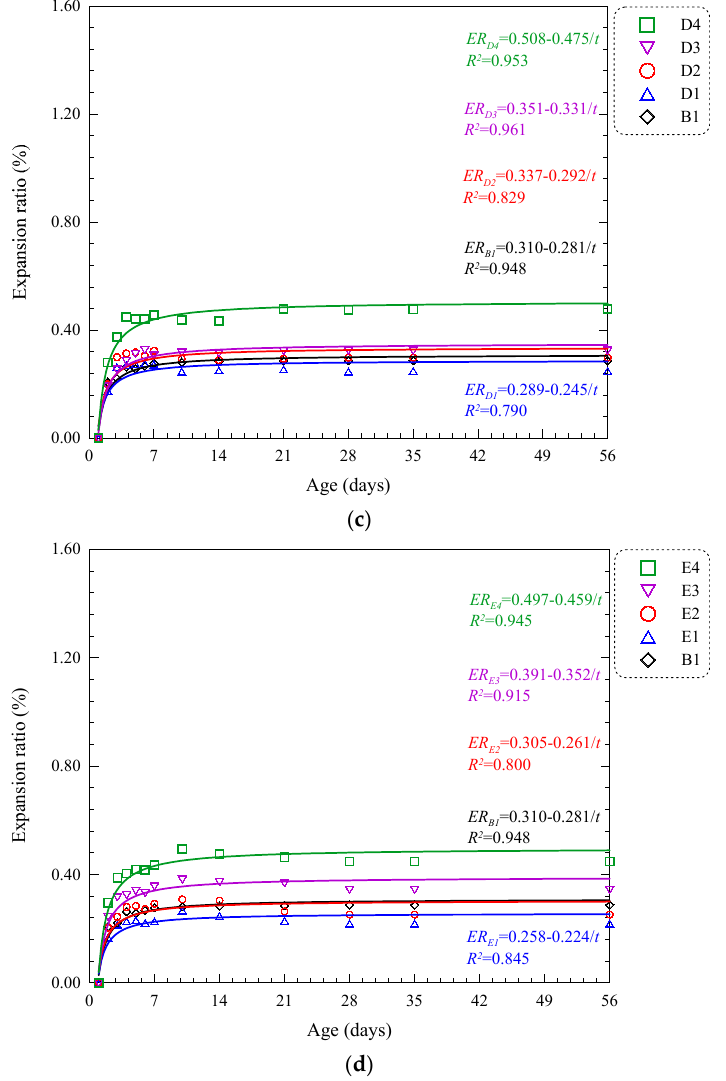
Figure 12. Expansion ratio of blended MOC pastes ( a ) Series B, ( b ) Series C, ( c ) Series D and ( d ) Series E. Except for the XRD analysis, micro-morphologies of MOC with solid waste ASR